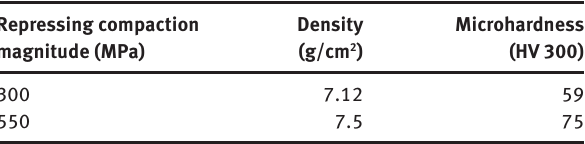
Table 2: Density and microhardness of the sintered and repressed